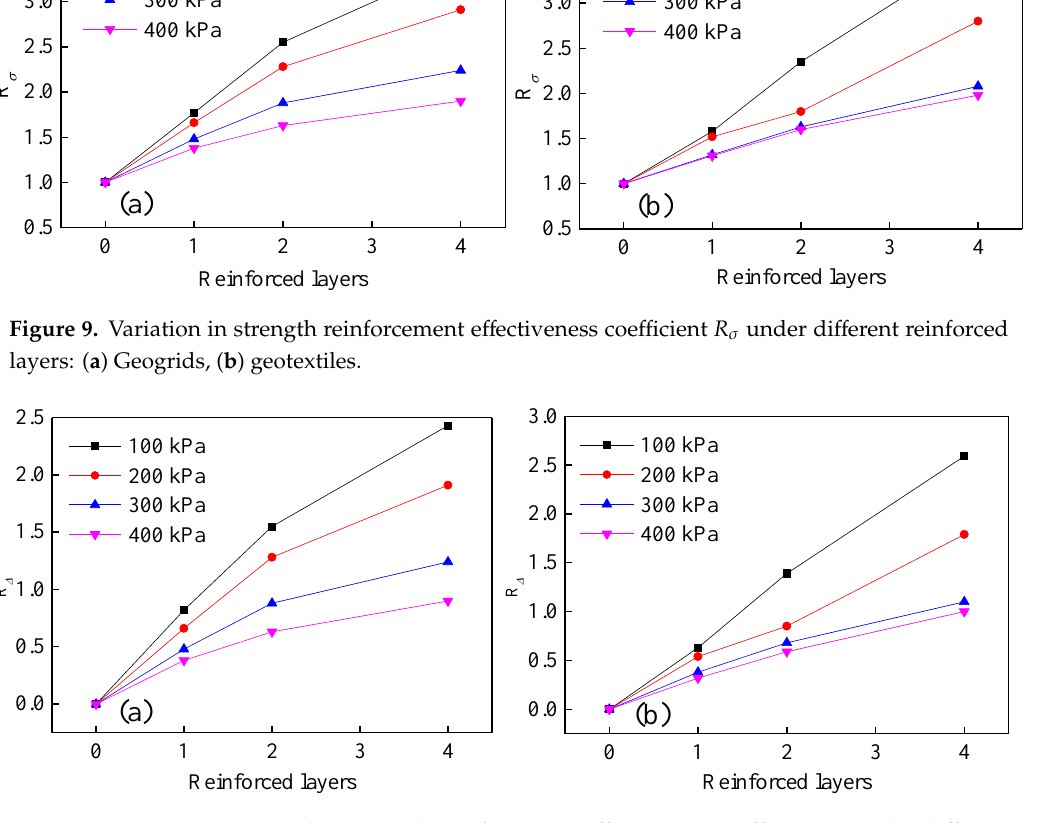
Figure 10. Variation in equivalent strength reinforcement e ff ectiveness coe ffi cient R ∆ under di ff erent reinforced layers: ( a ) geogrids, ( b ) geotextiles.